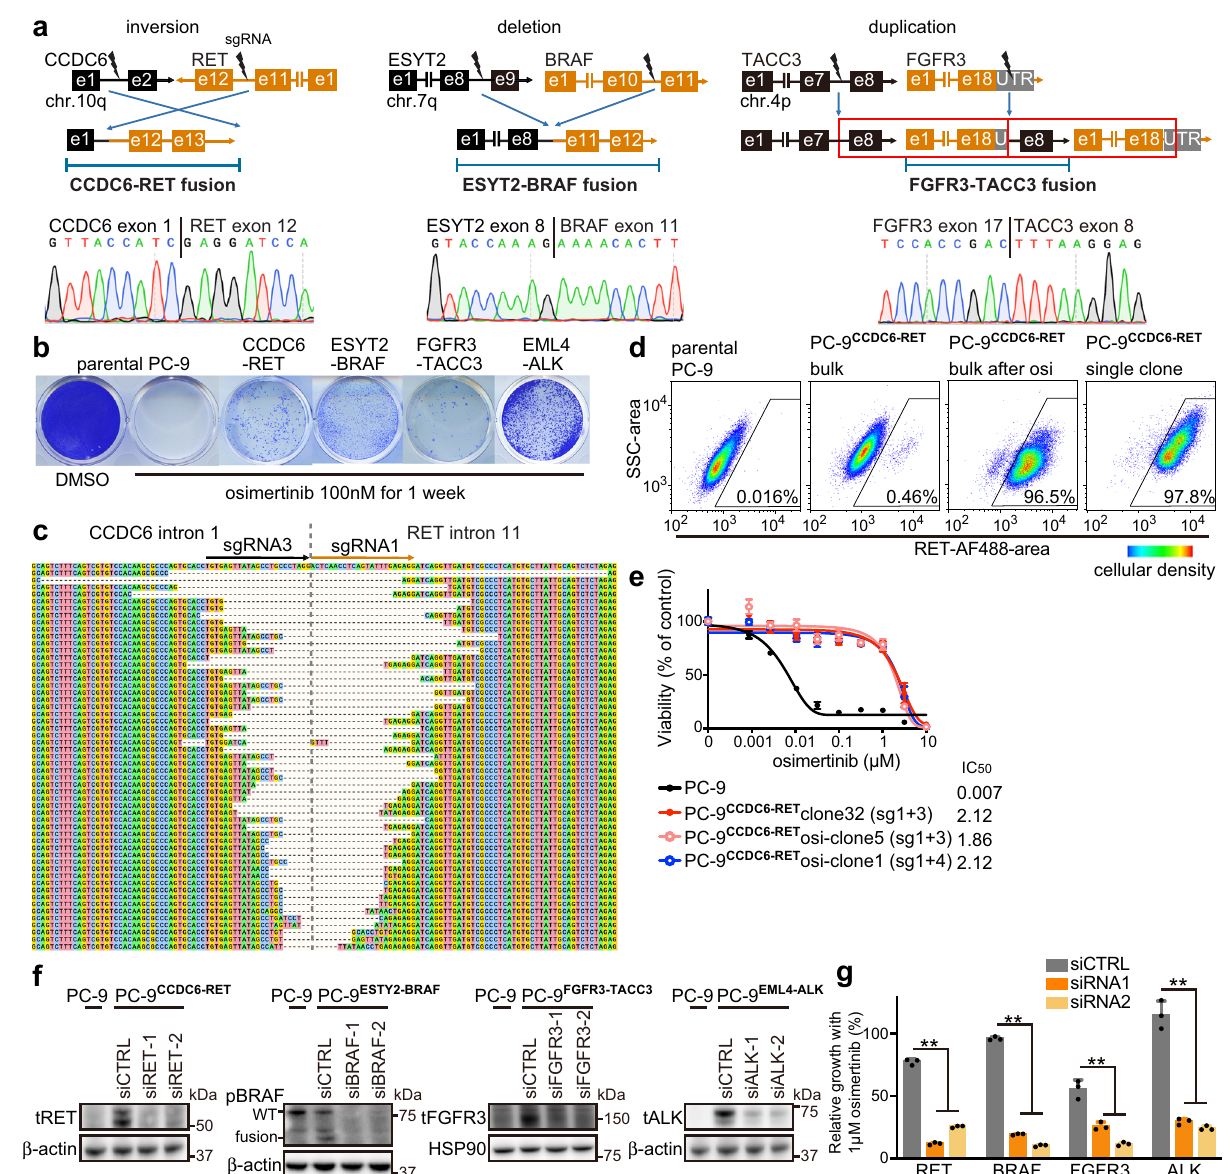
Fig. 5 | CRISPR-modi fi ed in vitro models, with EGFR mutation and oncogenic fusions. a The structures of the fusion oncogene and the location of designed single guide RNAs (sgRNAs) are shown, with representative sequencing chroma- tograms of fusion cDNA derived from bulk CRISPR-modi fi ed EGFR mutant PC-9 cells. e: exon; UTR: untranslated region. b Colony formation assay after 1 week of treatmentwithosimertinib,usingparentalPC-9cellsorCRISPR-modi fi edPC-9cells thatexpress fusiononcogenes. c Breakpoints of CCDC6-RET fusioninbulkCRISPR- modi fi ed PC-9 cells. d Expression of RET protein in permeabilized parental or CRISPR-modi fi ed PC-9 models, evaluated with use of fl owcytometry. PC-9 CCDC6-RET bulkcellswereselectedwith100nMosimertinibfor1week,andthenasingleclone was picked. Ratio of RET-expressing cells in each of four categories are indicated.